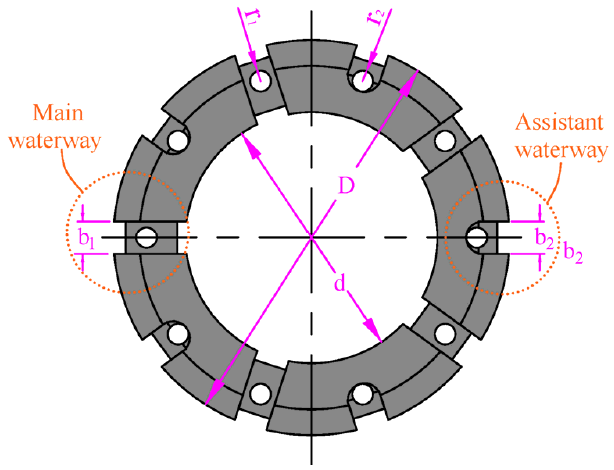
Figure 1. Bottom crown structure of